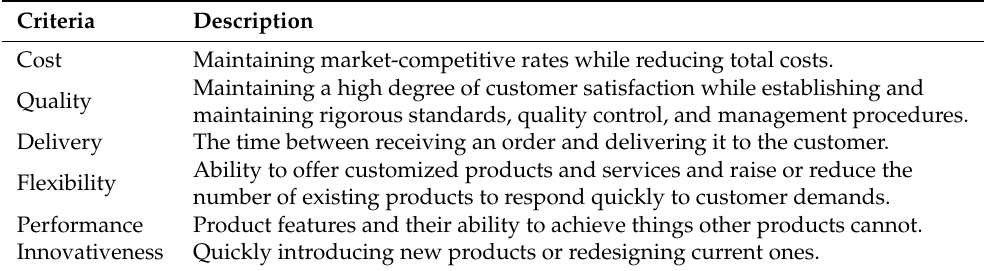
Table 1. Manufacturing strategies outputs